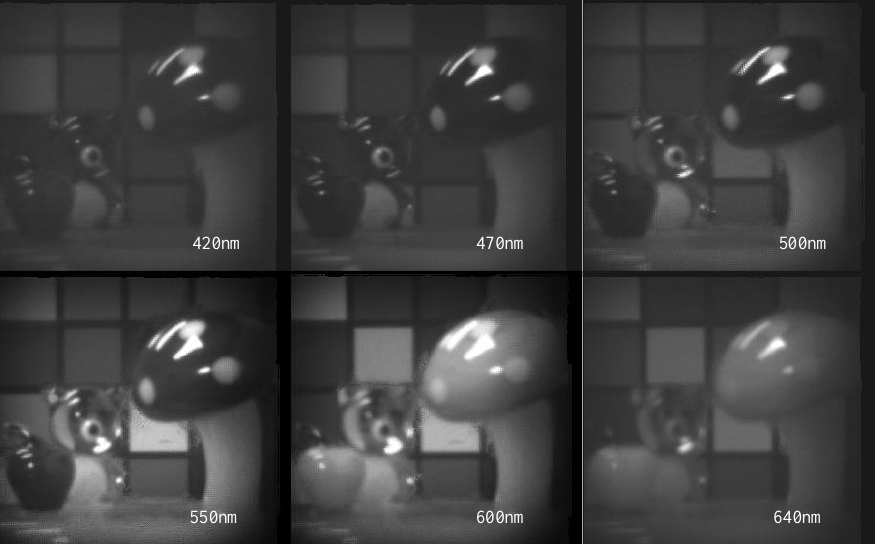
Figure 28. Multispectral images obtained from the experiments.